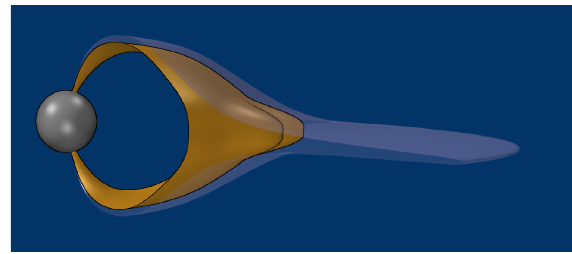
Fig. 10. A 3-D sketch showing how the tailward growth of fingers due to the development of the ballooning instability could protrude into the thin current sheet region. It is possible that such a scenario could lead to the onset of reconnection in the mid-tail region fol- lowing the initial growth of the ballooning instability closer to the